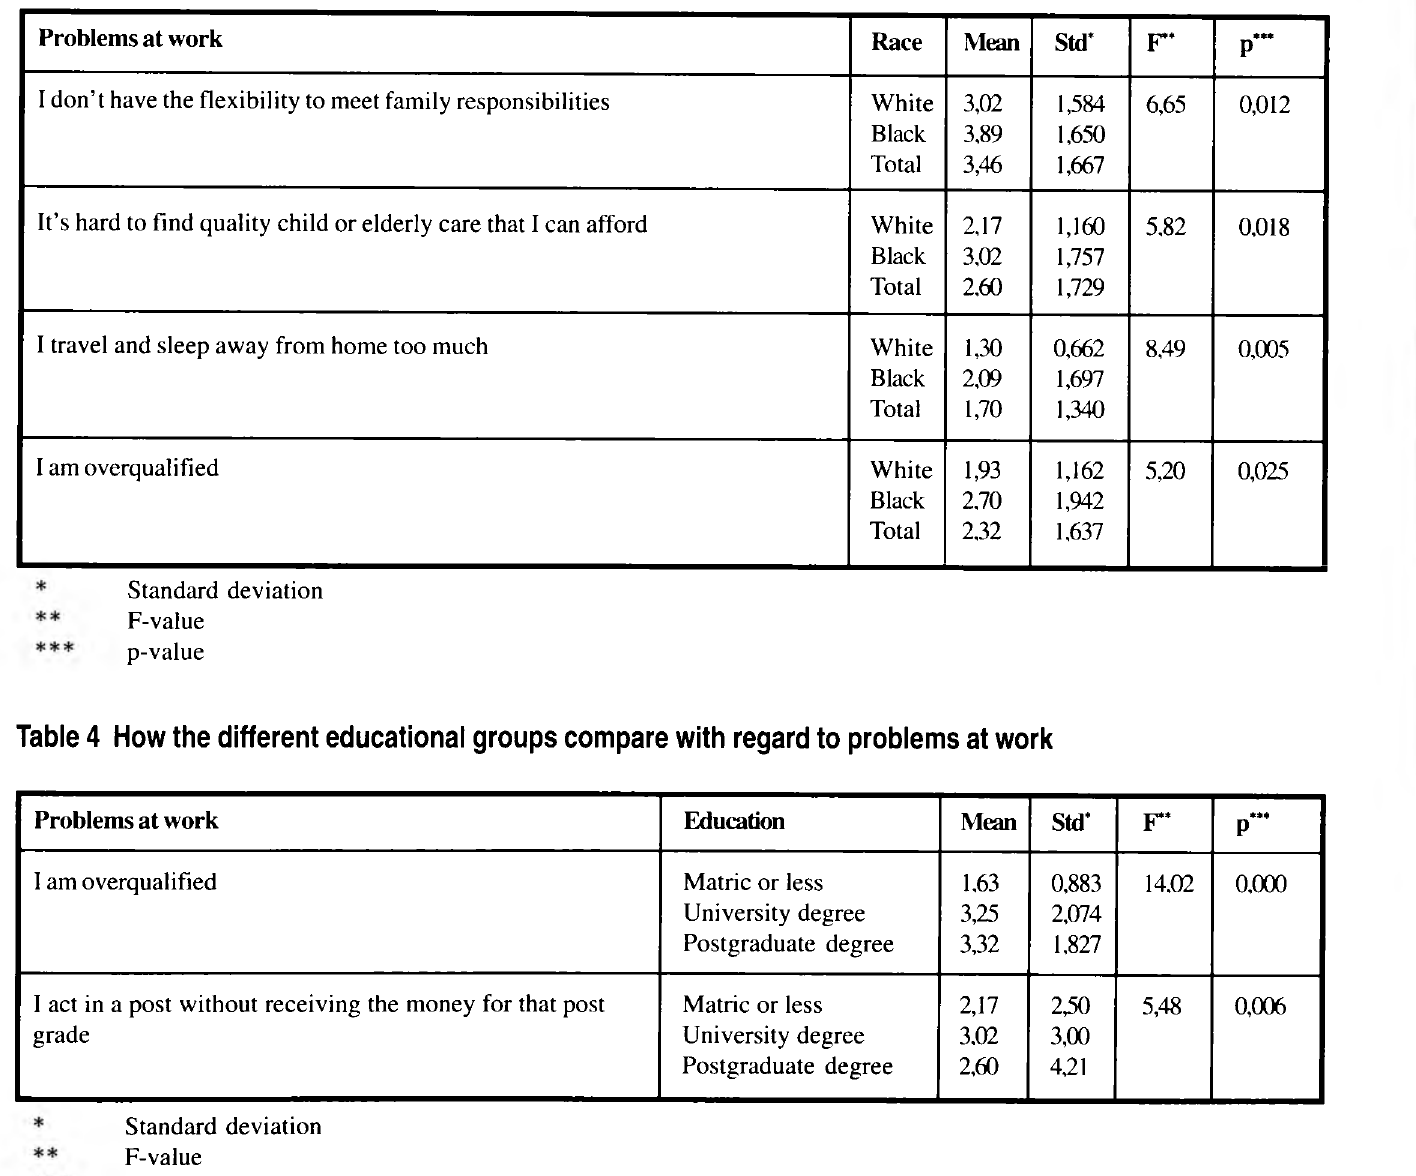
Table 3 How race groups compare with regard to problems at work Problems at work